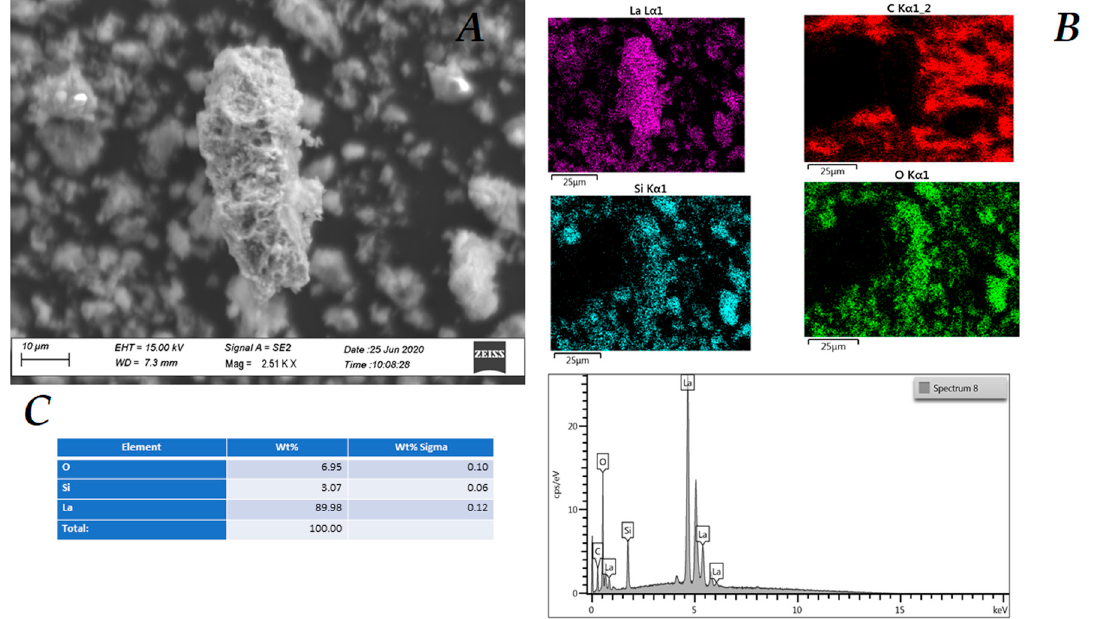
Figure 7. La(III) O-KIT-6 ( 2 ′ ) after three reaction cycles ( A ) SEM image at 10 μ m; ( B ) maps of elements, (C) EDS analysis and composition.